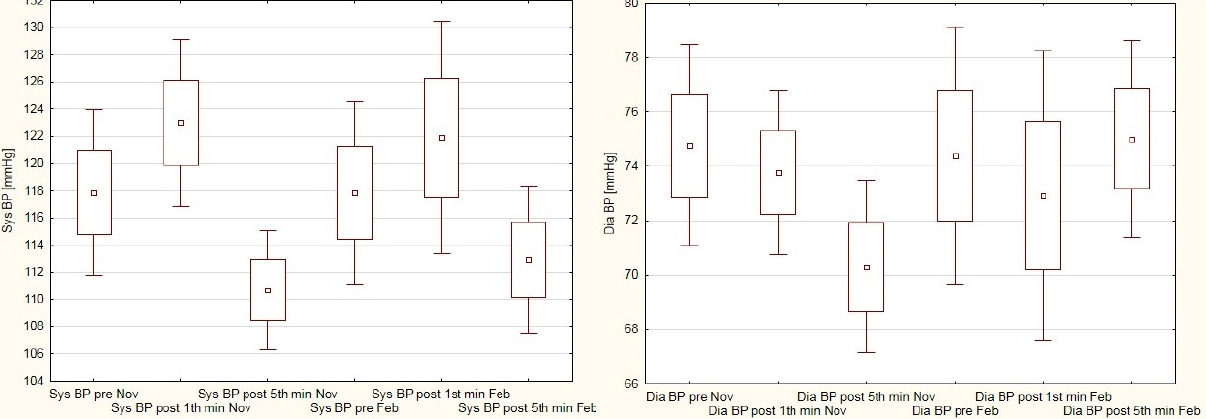
Figure 3. Blood pressure variations in female students in autumn and winter sessions of Physical Work Capacity 170